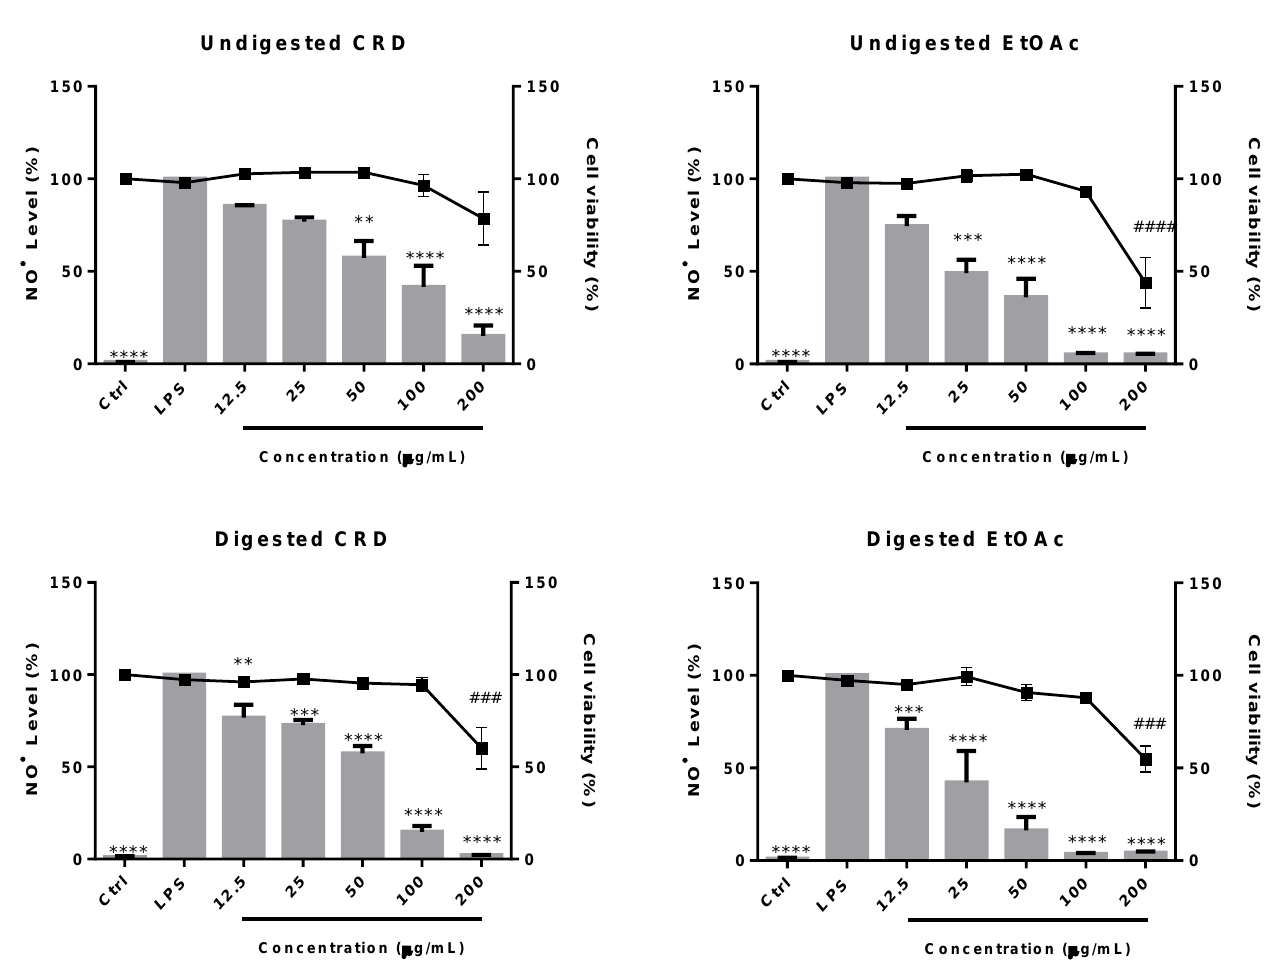
Figure 3. Effects of H. elongata crude extract (CRD) and ethyl acetate fraction (EtOAc) on the NO • production (grey bars) and viability ( ∎ ) of LPS-stimulated Raw 264.7 cells. Data represent the mean ± SEM from at least 3 independent experiments. ** p < 0.01, *** p < 0.001 and **** p < 0.0001, indicate that NO • production is significantly different from the positive control (with LPS), and ### p < 0.001 and #### p < 0.0001 indicate that cell viability is statistically different from the negative control (CTRL, without LPS), as determined by one-way ANOVA, followed by Dunnet’s post-hoc test.